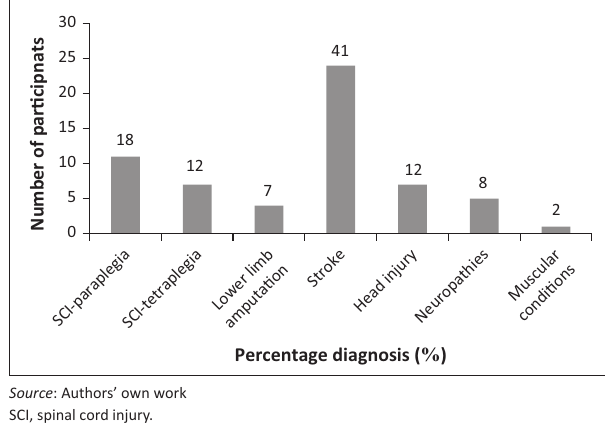
FIGURE 1: Medical diagnosis of participants (neuropathies included Guillian Barre and retroviral disease-related neuropathies; muscular conditions include muscular dystrophy) ( n =